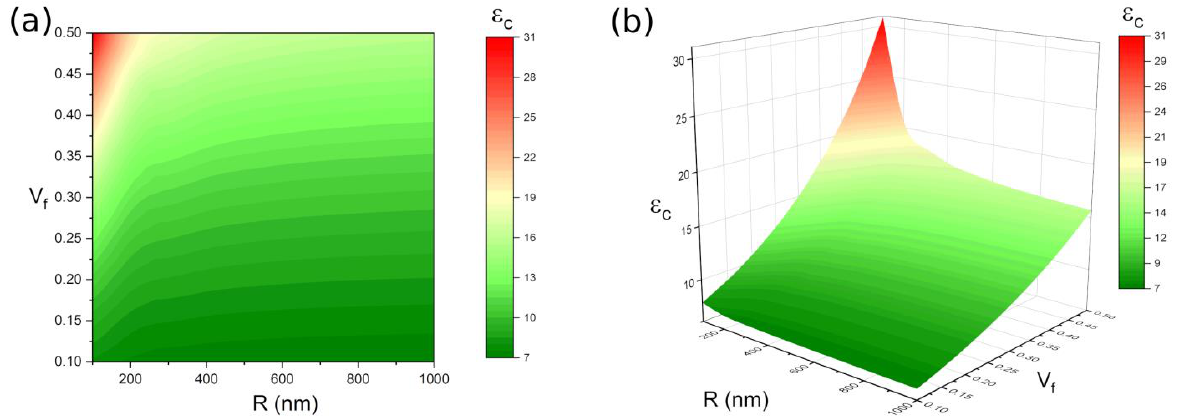
Figure 6. The dependence of ε c to the R and V f when ε f = 50, ε m = 6, ε i = 20, R i = 25 nm ( a ) contour plot; ( b ) 3D plot. 4. Conclusions